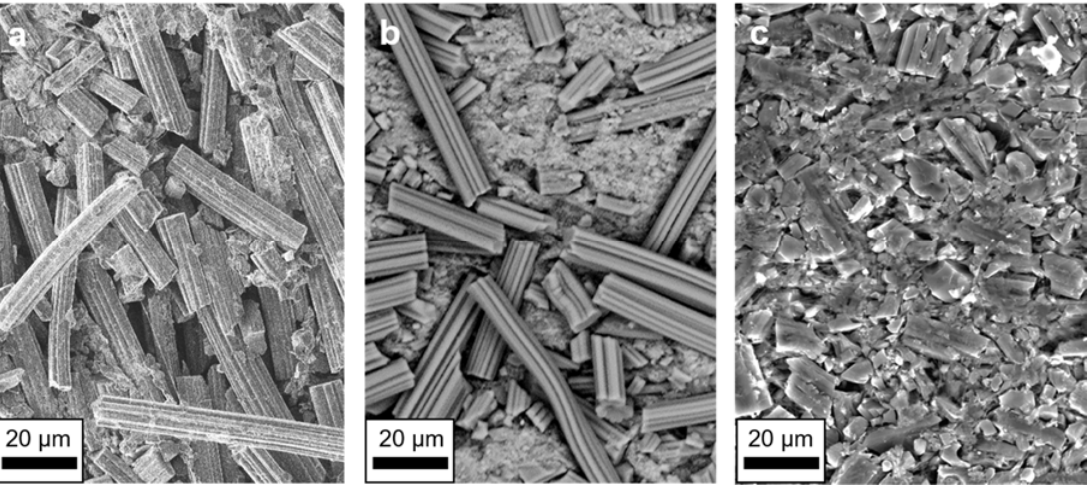
Figure 3. SEM micrographs of the electrode produced from the ACs activated with CO 2 ( a ), H 2 O ( b ), and KOH ( c ).